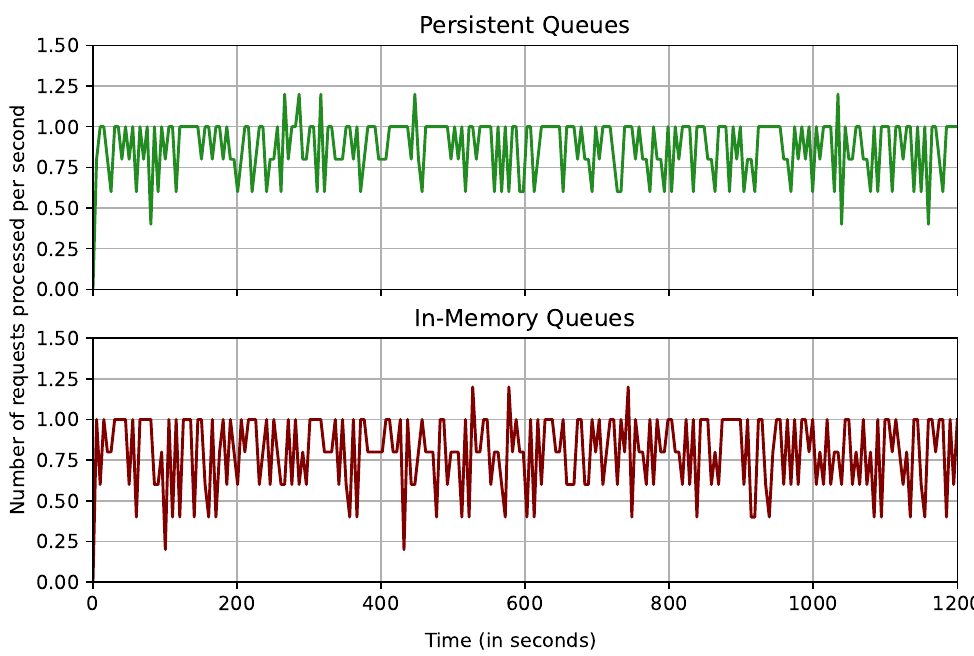
Figure 13. Results obtained when measuring the number of requests received where worker agents in the pipeline sleep for one second after processing an item. Measurements are carried out with persistent queues (top) and in-memory queues (bottom). The number of requests received is measured and reset every 5 s. The plot shows number of requests per second over each 5 s